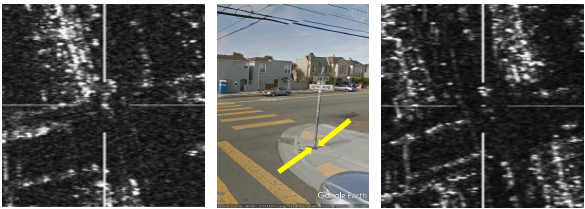
Figure 5. Example of a SAR measurement (Lawton Street, San